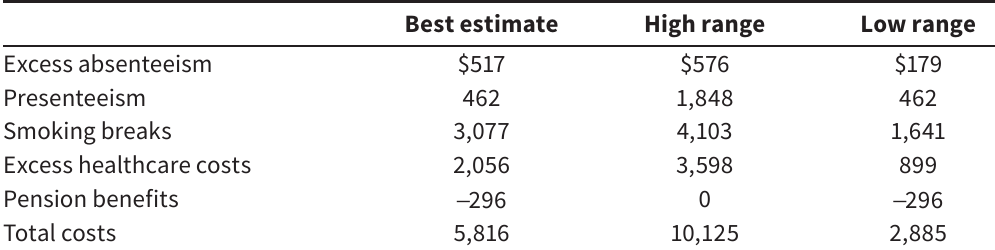
The annual costs of a smoker (in 2010 dollars) Best estimate High range Low range Excess absenteeism $517 $576 $179 Presenteeism 462 1,848